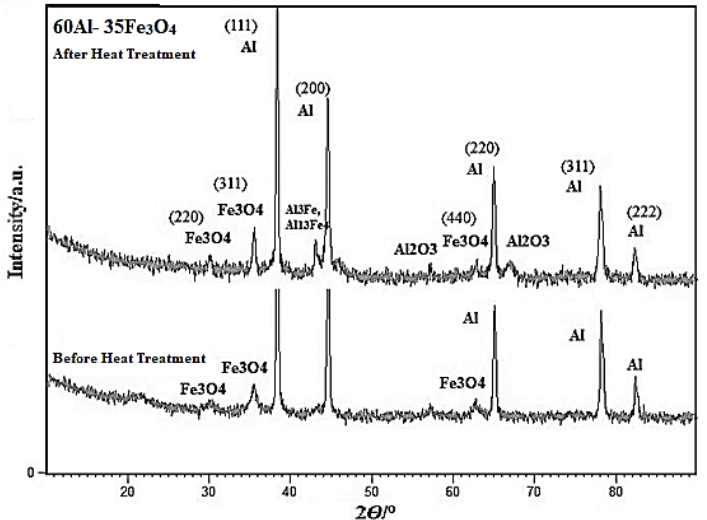
Figure 8. XRD analysis for the a.5 composite before and after sintering.